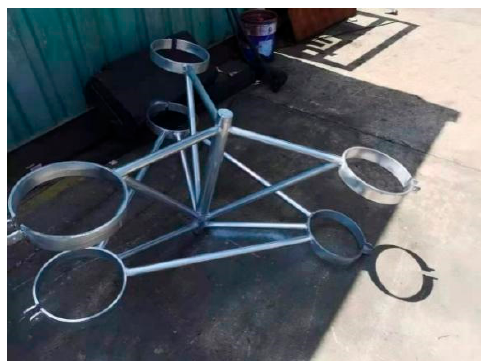
Figure 4. Simplified main pontoon and connection frame.